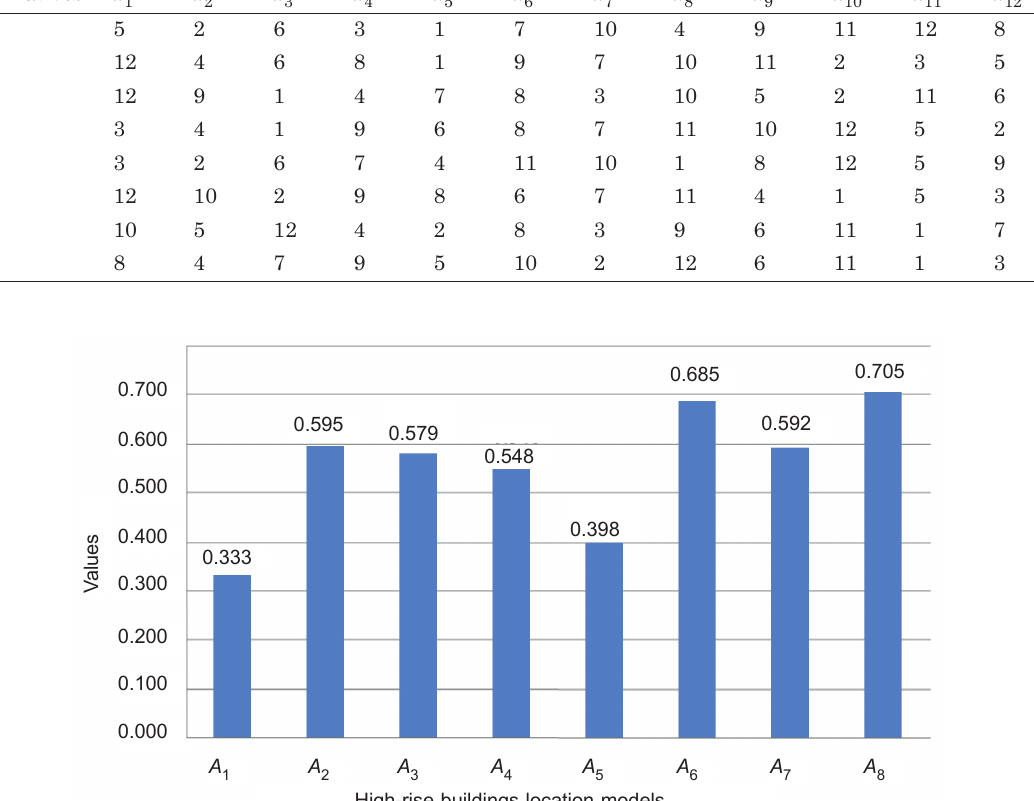
figure 4. the ways to locate high-rise buildings in the urban structure assessed using the SAW